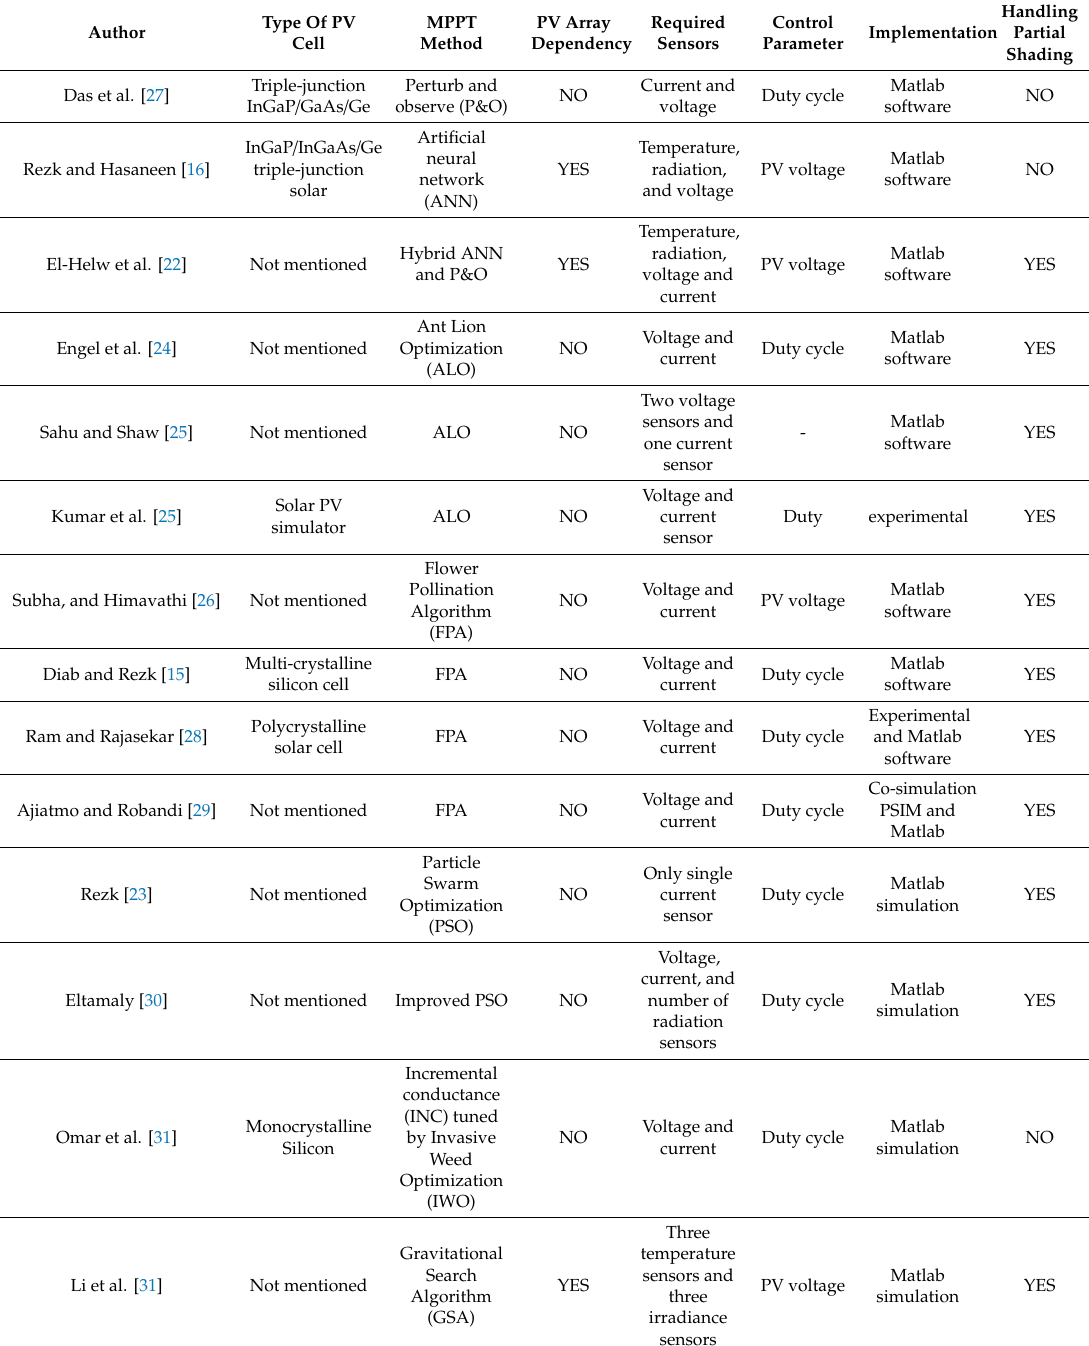
Table 1. Summary of some selected previous maximum power point tracking (MPPT)